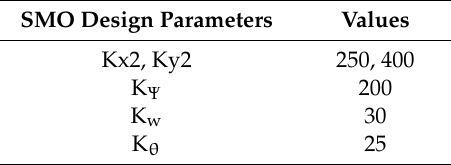
Table A2. SMO design